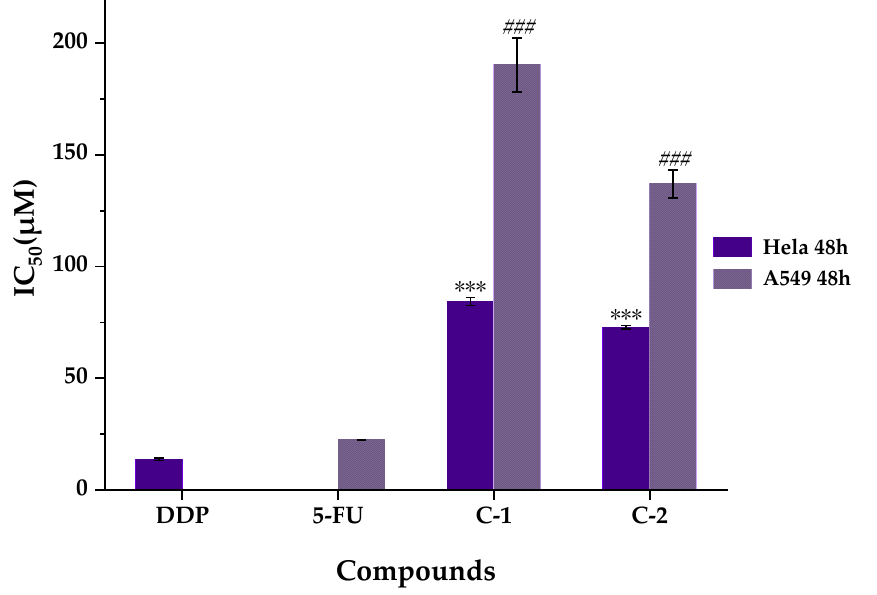
Figure 6. Anti-proliferative activities of compounds isolated from WE-P of W. ugandensis . DDP, Cisplatin; 5-FU: 5-Fluorouracil; C-1, compound 1 ; C-2, compound 2 ; Hela: Human cervical cancer cell line; A549: Human non-small cell lung adenocarcinoma cell line; IC 50 : The half-maximal inhibitory concentrations. *** p < 0.001, compared with cisplatin group (DDP); ### p < 0.001, compared with 5-fluorouracial group (5-FU).